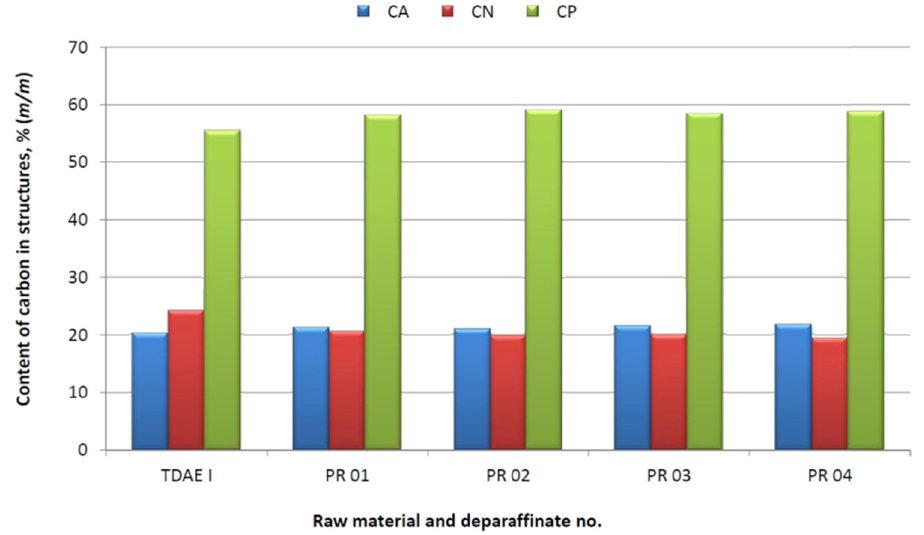
Figure 2: E ff ects of the dewaxing process with the MEK – TOL solvent on the change of the structural composition of depara ffi nates – TDAE I raw material.